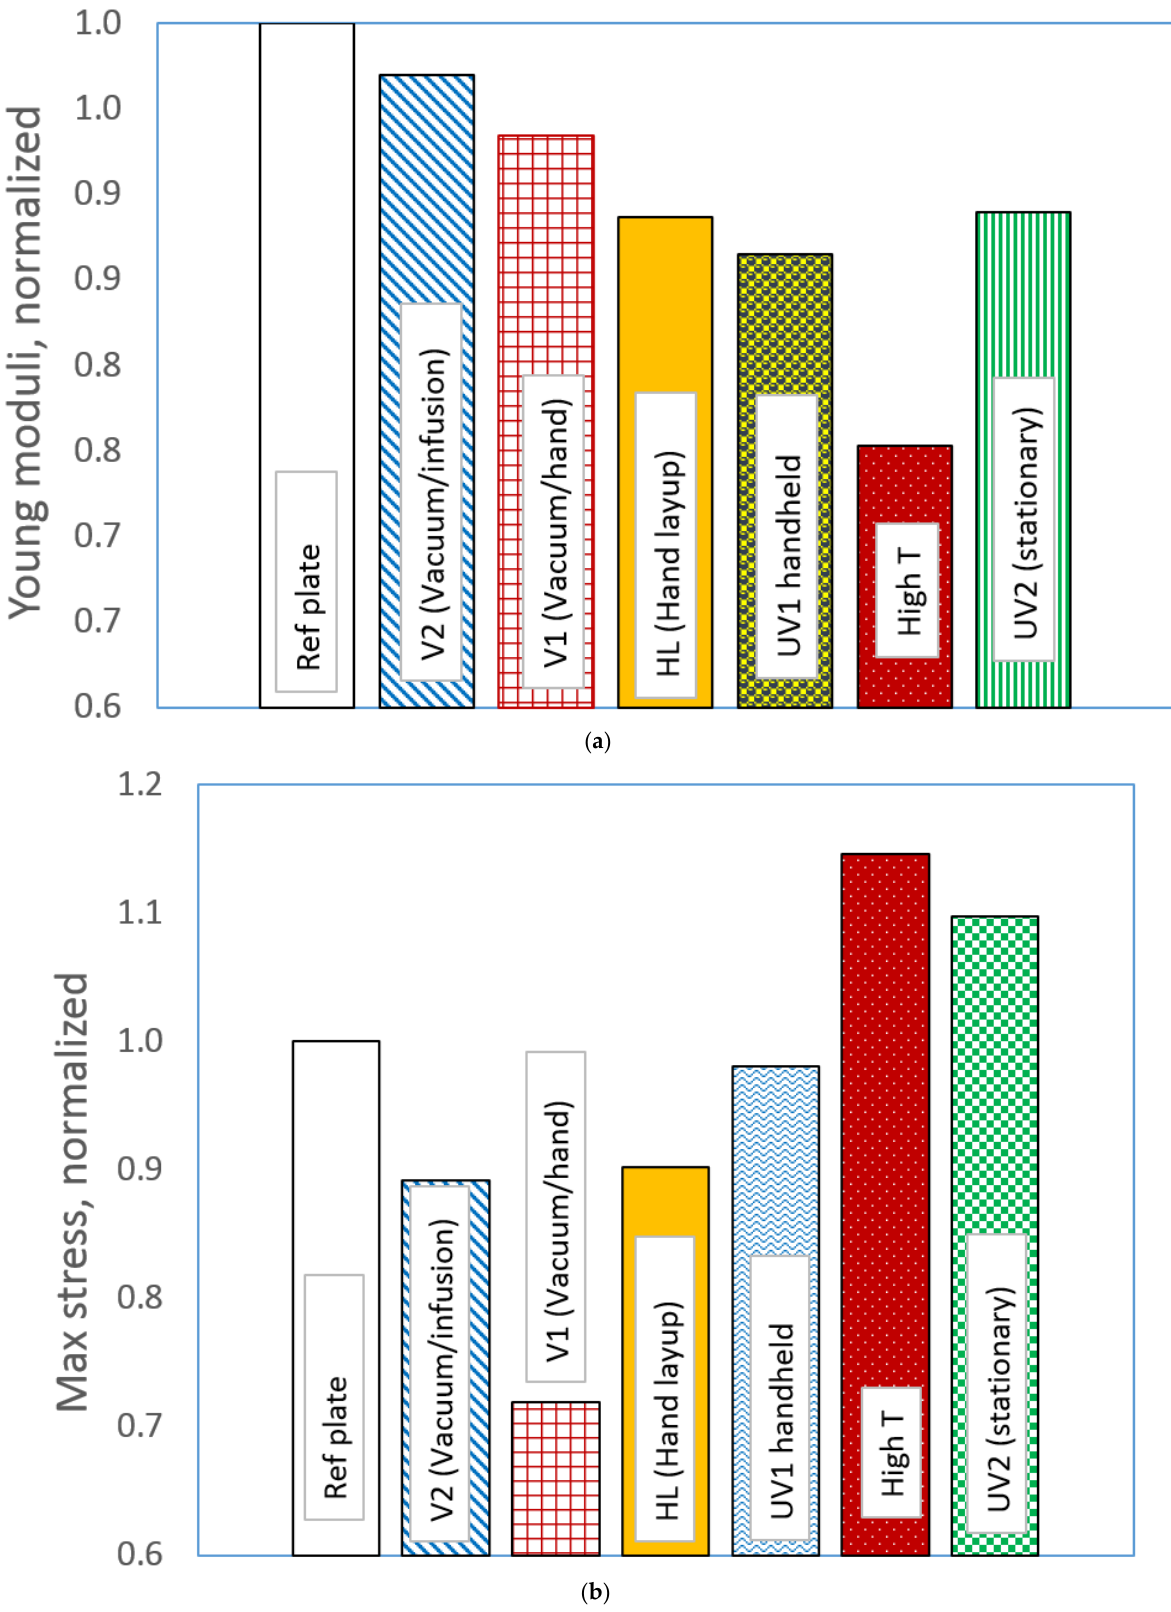
Figure 4. Comparison of different repair technologies, ( a ) relative (normalized by reference/unrepaired case) Young moduli, and ( b ) relative (normalized by unrepaired case) strengths of samples.